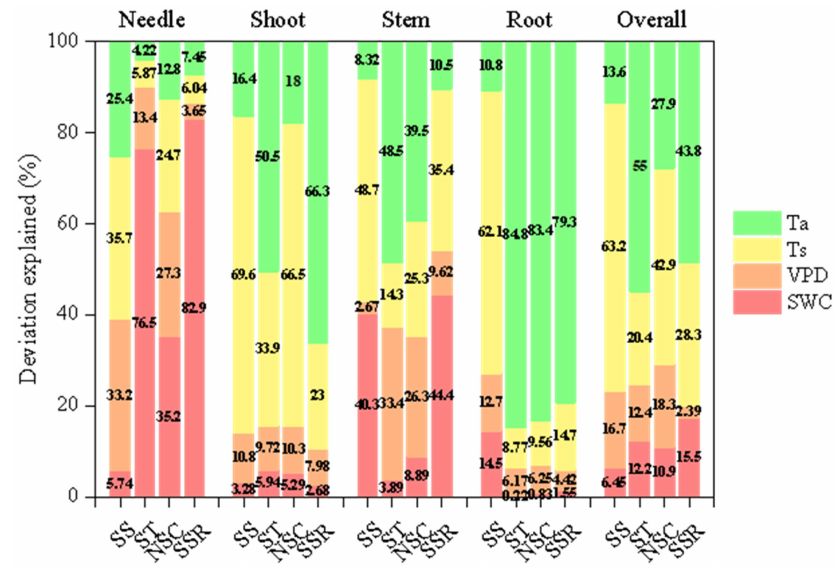
Figure 4. Interpretation rate of the environmental variables to soluble sugars (SS), starch (ST), NSC, and soluble sugar–starch ratios (SSR) in different organs based on a linear mixed